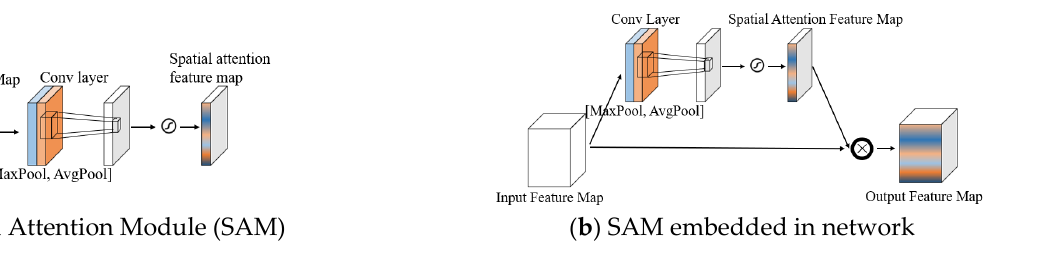
F represents the output feature map after em- s M